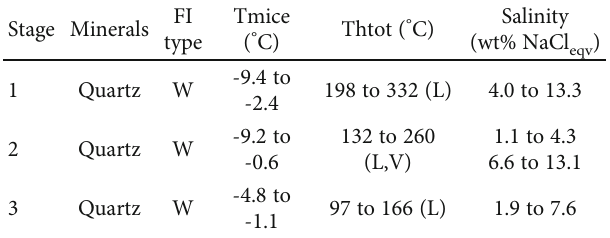
Figure 7: Photomicrographs of FI types from Longmendian deposit: (a – d) W-type FIs composed of vapor H di ff erent gas-liquid ratios of W-type FIs coexist. Table 1: Microthermometric data of W-type FIs from quartz in the Longmendian Ag-Pb-Zn